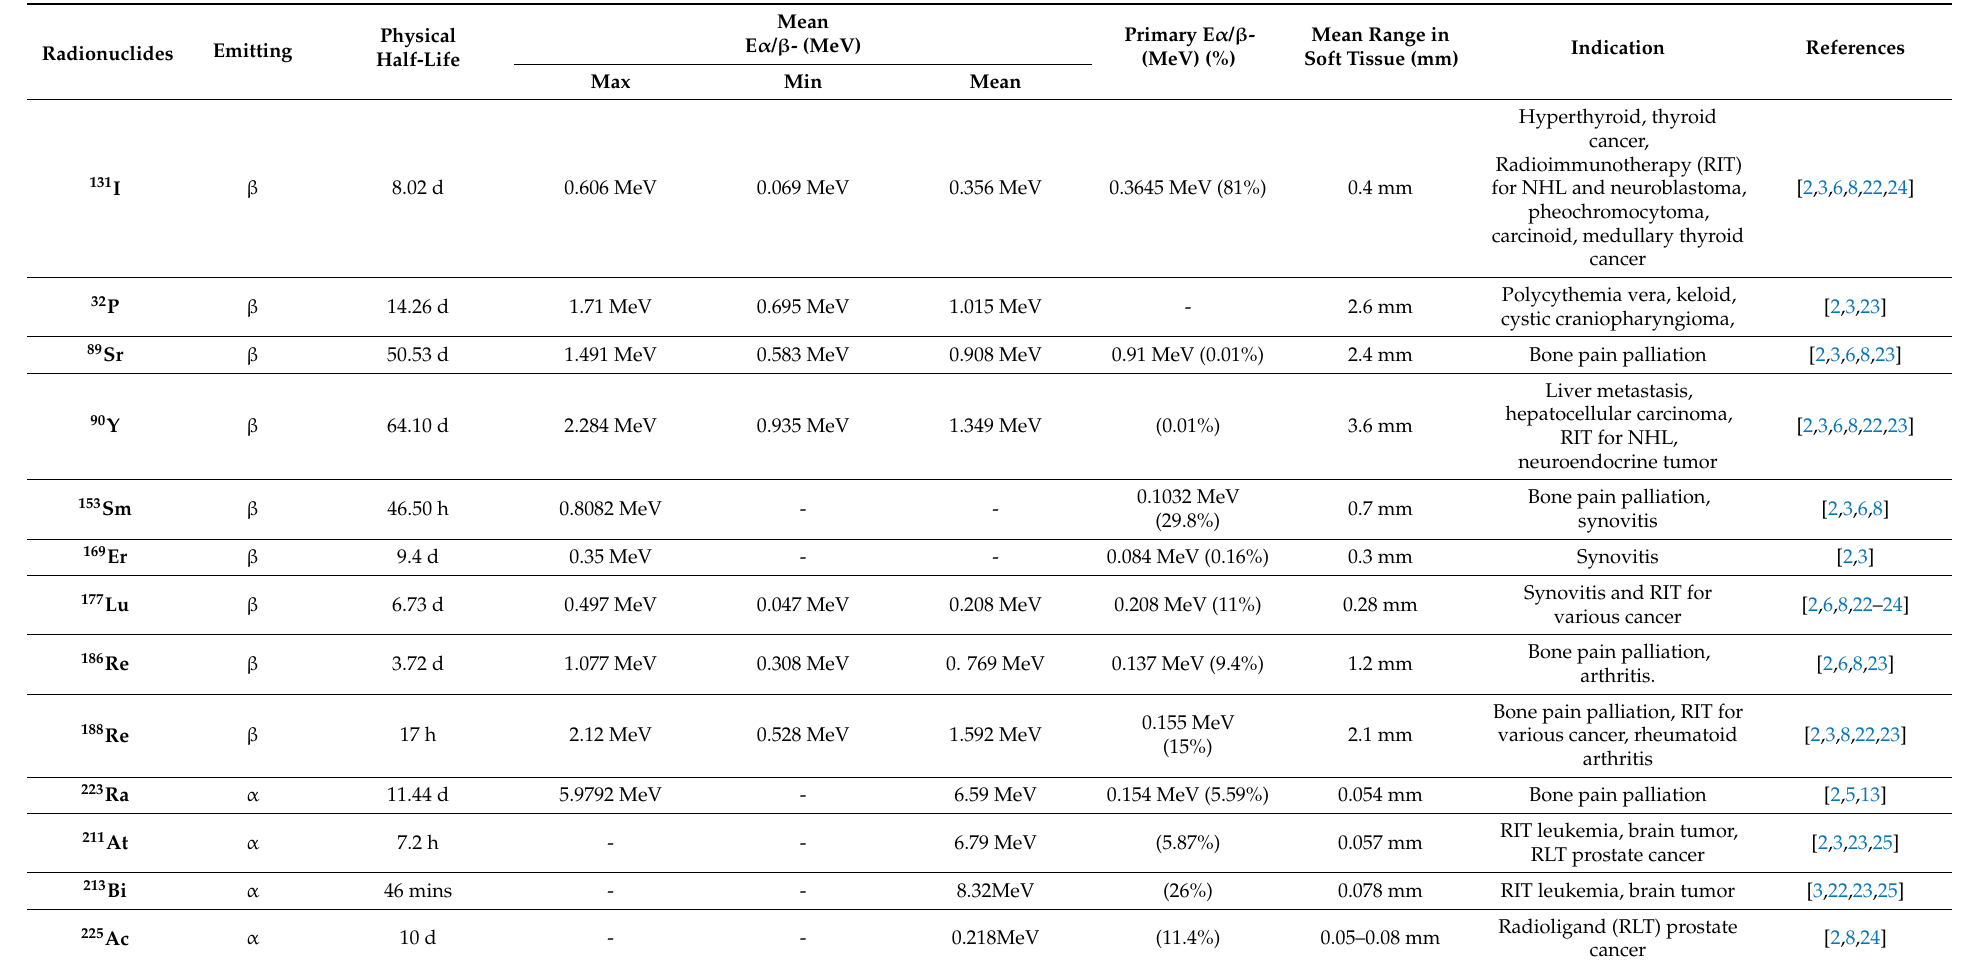
Table 1. Characteristics of radionuclides used in